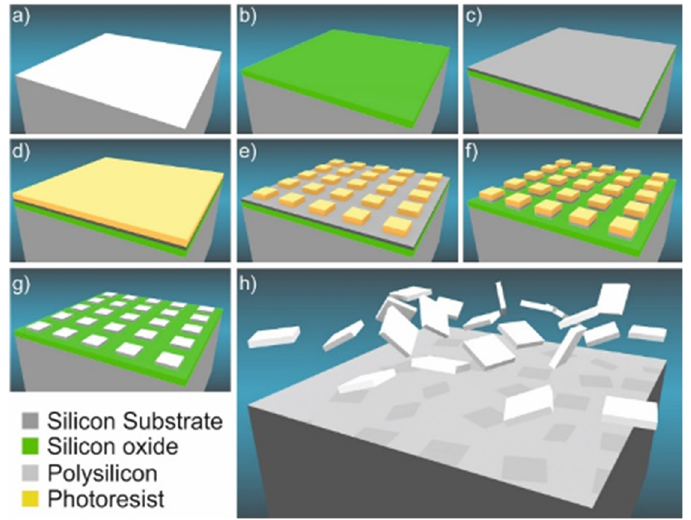
Figure 3. Fabrication of the polysilicon substrates. ( a ) Silicon wafer starting substrate. ( b ) Thermal growing of a 1 µm-thick silicon oxide (sacrificial layer). ( c ) Deposition of a 500 nm-thick CVD polysilicon layer (structural layer). ( d ) 1.2 µm-thick photoresist layer deposition. ( e ) Photolithographic step to define lateral dimensions. ( f ) Vertical dry etching of the polysilicon layer. ( g ) Removing of the photoresist layer to obtain the Poly-Surfs. ( h ) Etching of the sacrificial layer in HF vapors and release of Poly-Si μ Ps.